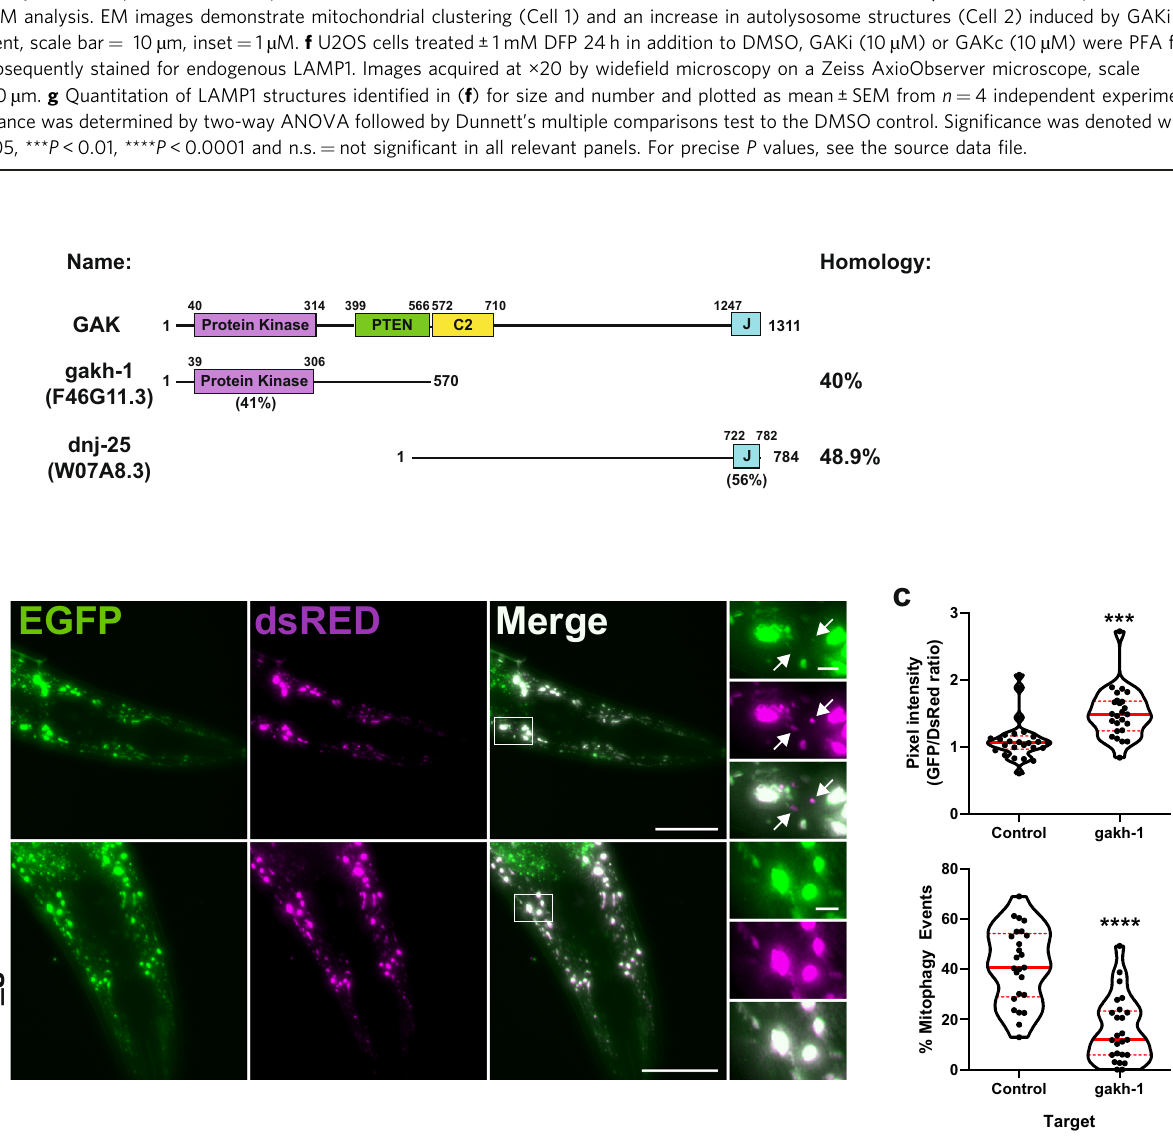
Fig. 8 gakh-1 regulates basal mitophagy in vivo. a Schematic representation of GAK domain structure and orthologues gakh-1 and dnj-25 present in C. elegans . Homology values were obtained by protein blast alignment. b In vivo detection of mitophagy in C. elegans . Transgenic nematodes expressing mtRosella in body-wall muscle cells were treated with gakh-1 RNAi or pL4440 control vector. dsRED only structures represent mitochondria in acidic compartments (arrowheads). Scale bar = 50 μ m, insets = 5 µ m. Representative image from n = 25 worms. c Mitophagy stimulation signi fi ed by the ratio between pH-sensitive GFP to pH-insensitive dsRED ( n = 25 worms per group, upper panel). Quanti fi cation of the frequency of mitochondria undergoing mitophagy (dsRED puncta lacking EGFP co-localisation) are expressed as a percentage of total mitochondria detected ( n = 25 worms per group, lower panel). The data are presented as violin plots of individual values with median (red, solid line) and quartiles (red, dashed line) shown. Signi fi cance was determined by unpaired two-tailed t test from n = 2 independent experiments, where ** P < 0.001 or **** P < 0.0001. For precise P values, see the source data fi